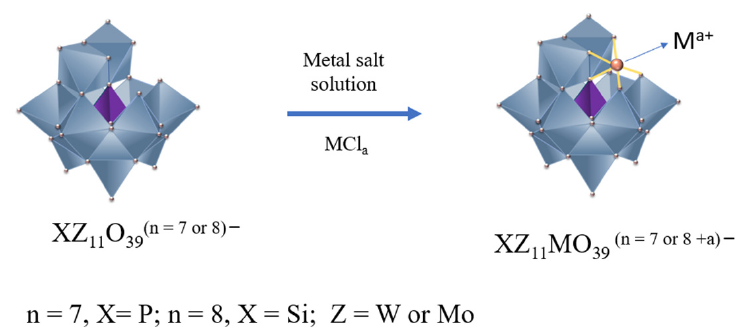
Scheme 6. Synthesis of metal-doped phosphotungstate, phosphomolybdate, and silicotungstate